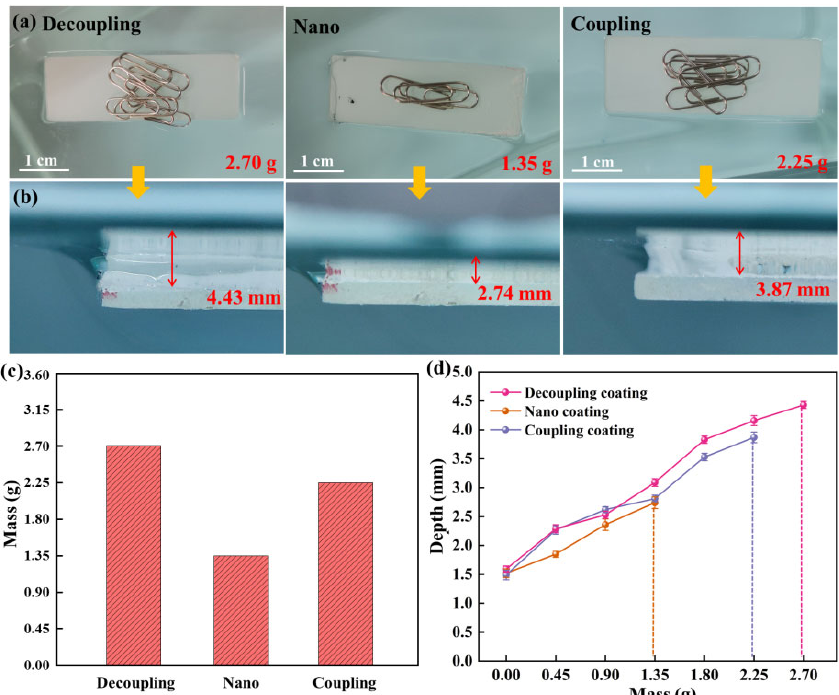
Fig. 9 (a) Optical images of maximum load carried by the decoupling, nano, and coupling coatings; (b) optical images of maximum depth of three coatings sinking into water; (c) carrying capacity of three coatings; and (d) depths of samples sinking into water as a function of